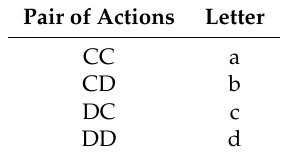
Table 4. Associating a letter to each possible outcome of the prisoner’s dilemma (PD) game.